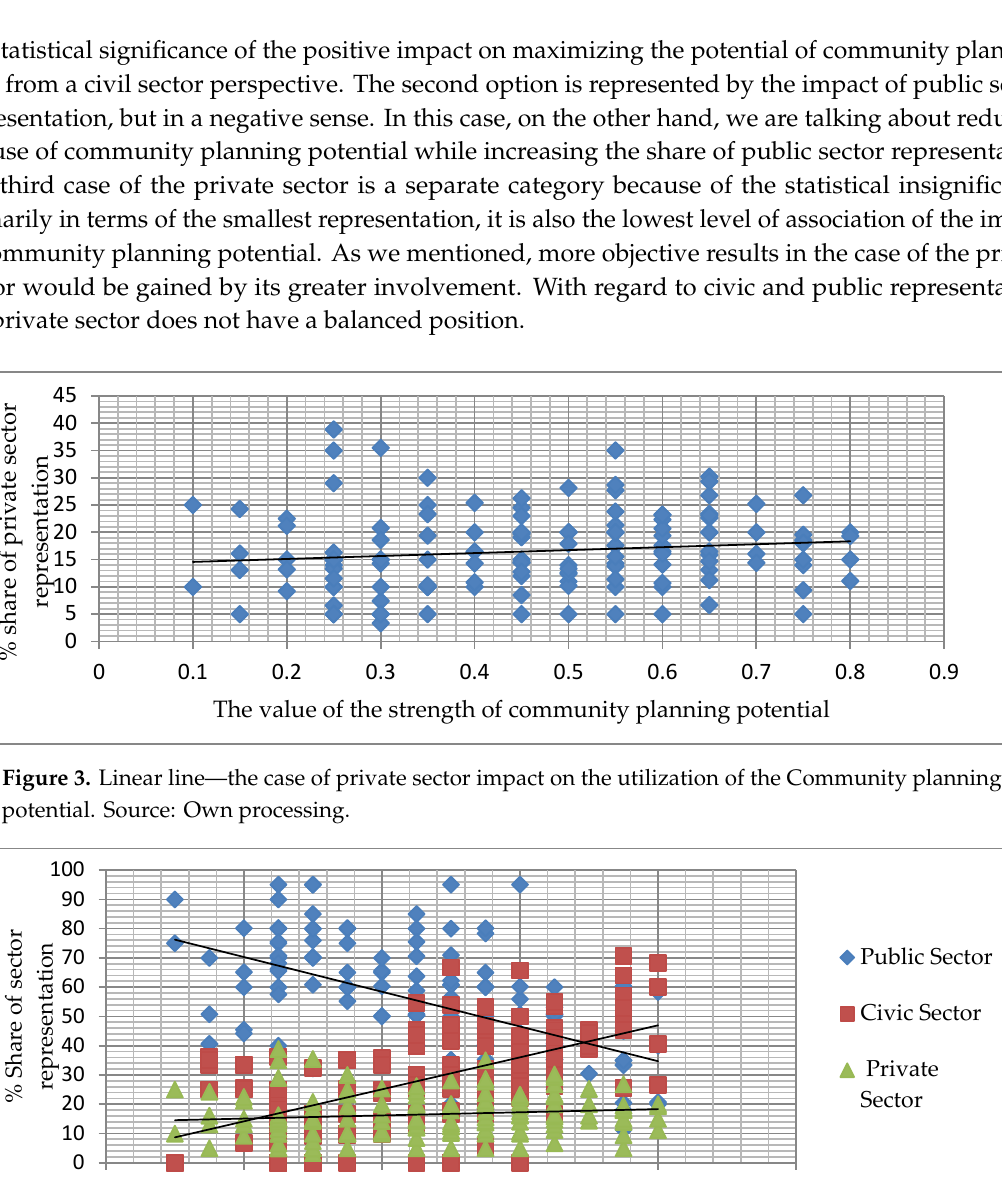
Table 6. Correlation—% share of private sector representation and utilization of the Community planning of social services potential.